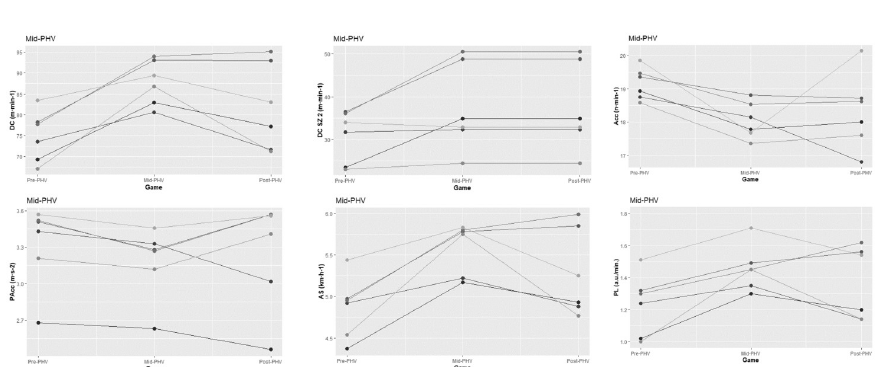
Fig 3. Individual graphical representation of significant differences in physical and tactical performance between game formats amongst Mid-PHV athletes.